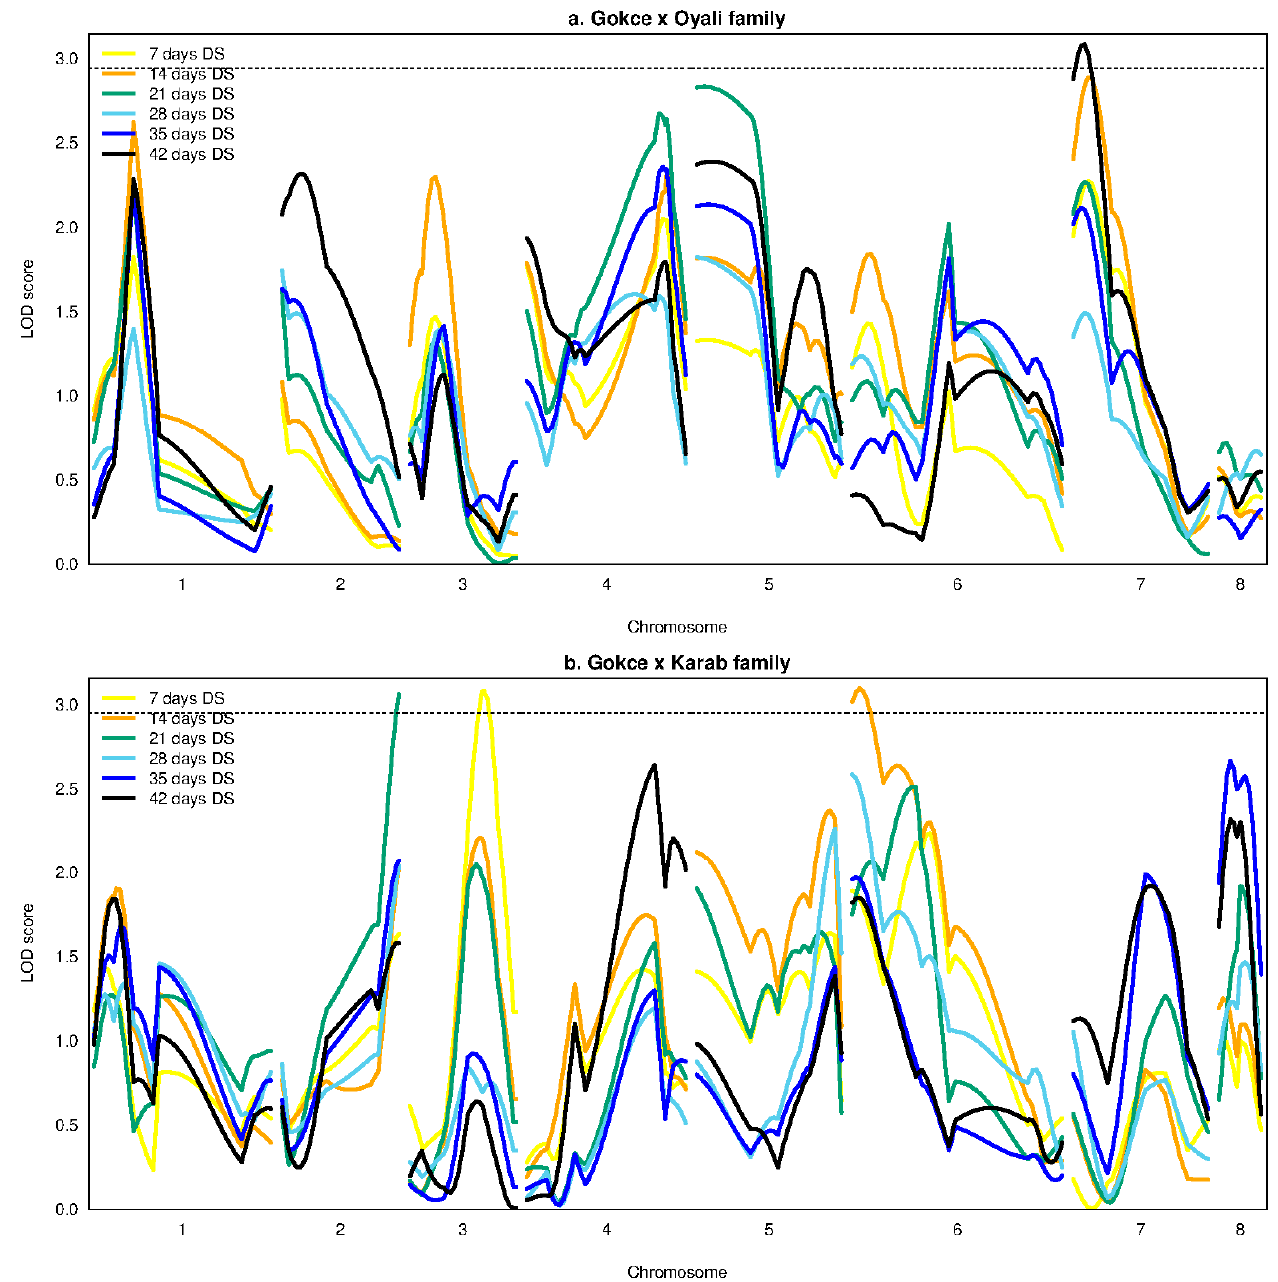
Figure 3. Logarithm of odds (LOD) values against genetic map position for Ascochyta disease scores at different times since inoculation for the chickpea Gokce × Oyali (panel a ), Gokce × Karab (panel b ) families. Each line color represents disease scores (DS) for a different time as shown in the legend. The horizontal dashed line is the LOD threshold calculated from 5000 permutations above which LOD scores indicate significant quantitative trait locus (QTL) peaks.